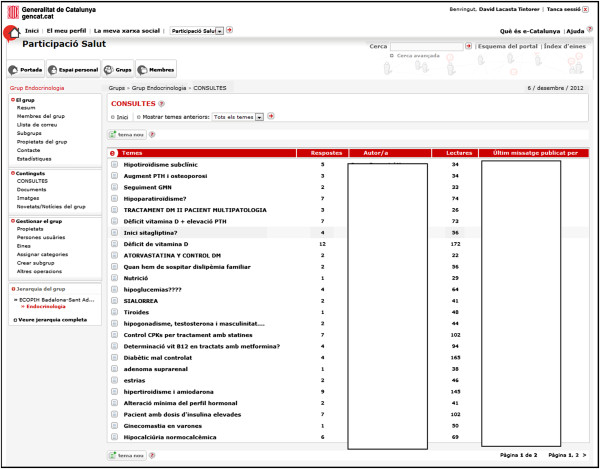
Consultations Forum.